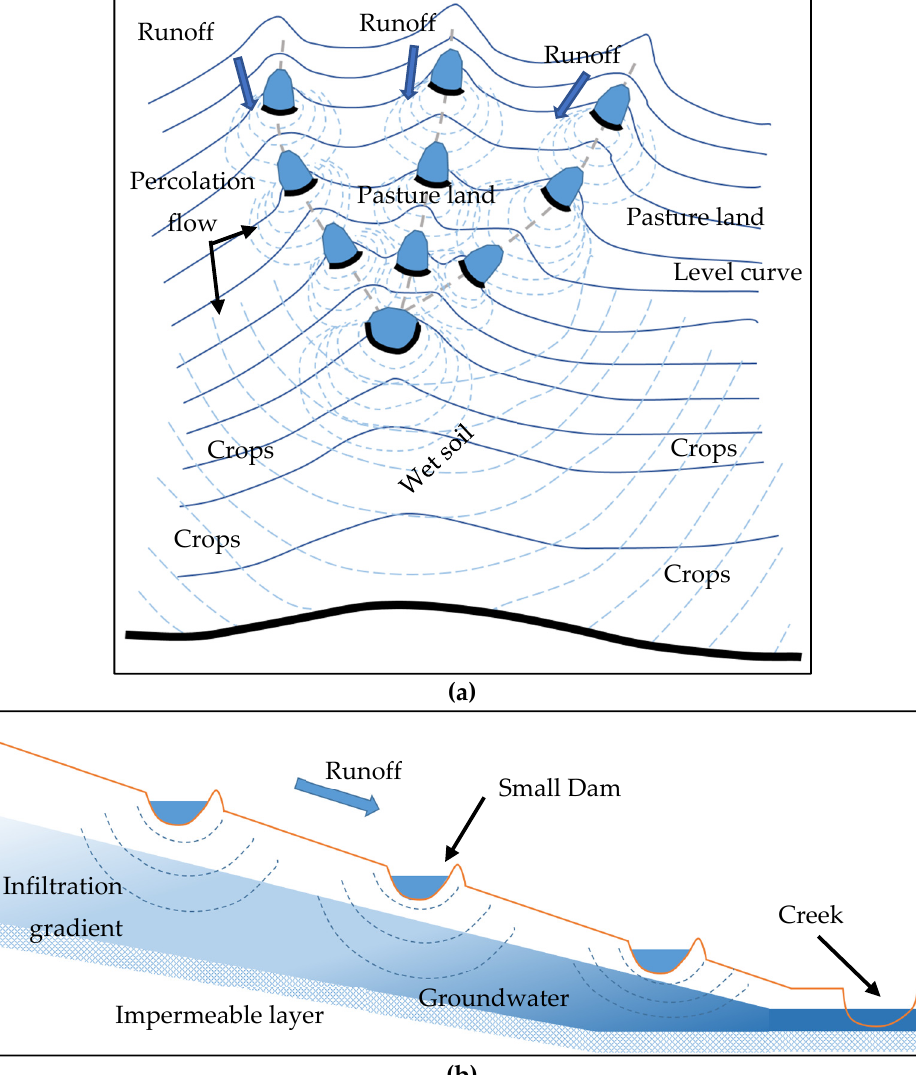
Figure 3. Small Dam scheme: ( a ) example of a scattered located small dam scheme; ( b ) cross section of a small dam of a small dam scheme.